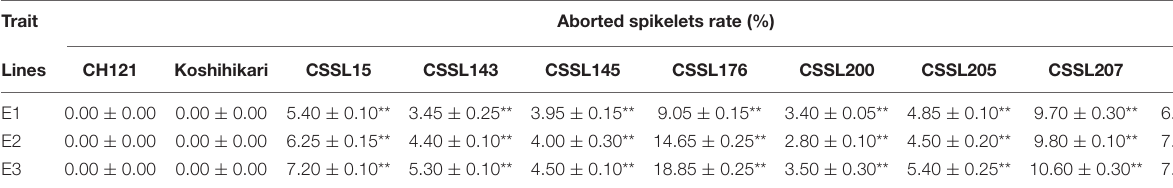
TABLE 2 | Aborted spikelets rate of CH121, Koshihikari and 8 CSSLs. Trait Aborted spikelets rate (%) Lines